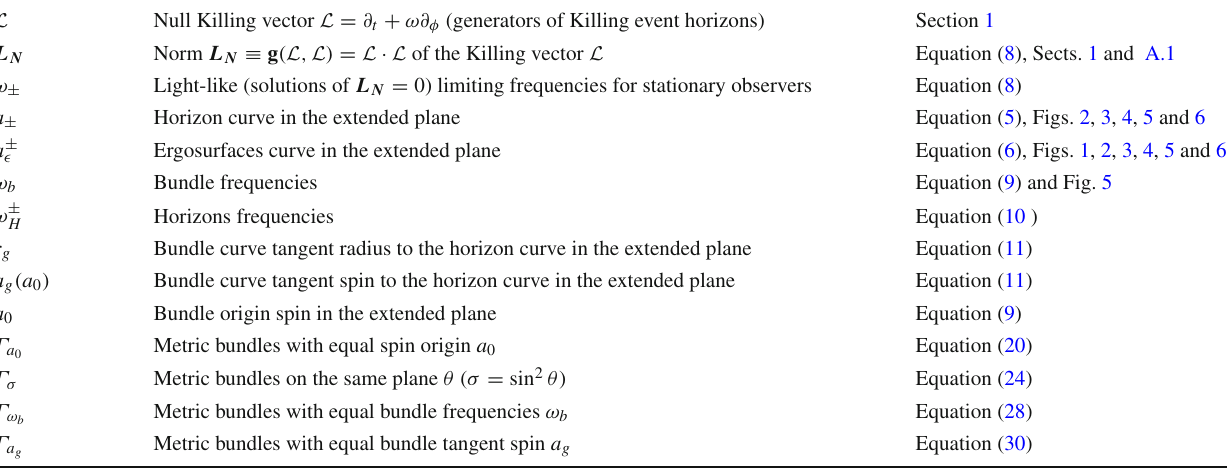
Table 1 Lookup table with the main symbols and relevant notations used throughout the article with a brief description and reference to the first place where they appear